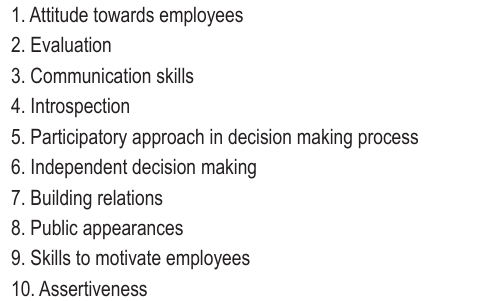
TABLE 5. Rank list of specific managerial skills that should be developed and improved between managers ‑ medical doctors in the primary health